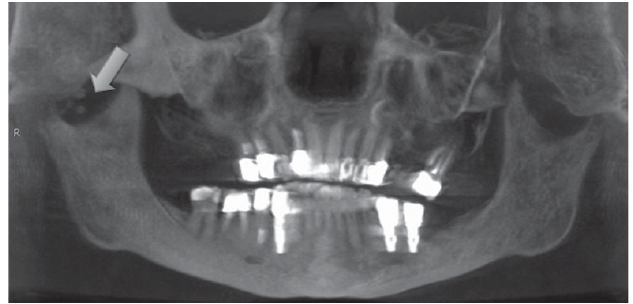
Fig. 5. Case 3. Panoramic view of CBVT. Arrow points to the loose bodies and a mass originating from the temporal bone.